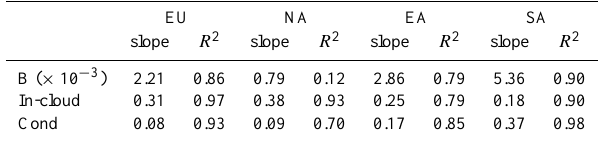
Table 4. Relationships, in Tg(S) per Tg(S) emitted, calculated for the period 1980–2005 between sulfur emissions and SO 2 − (B), SO 2 − production from SO 2 in-cloud oxidation (In-cloud), and 4 SO 2 − gaseous phase production (Cond) over Europe (EU), North 4 America (NA), East Asia (EA), and South Asia (SA).